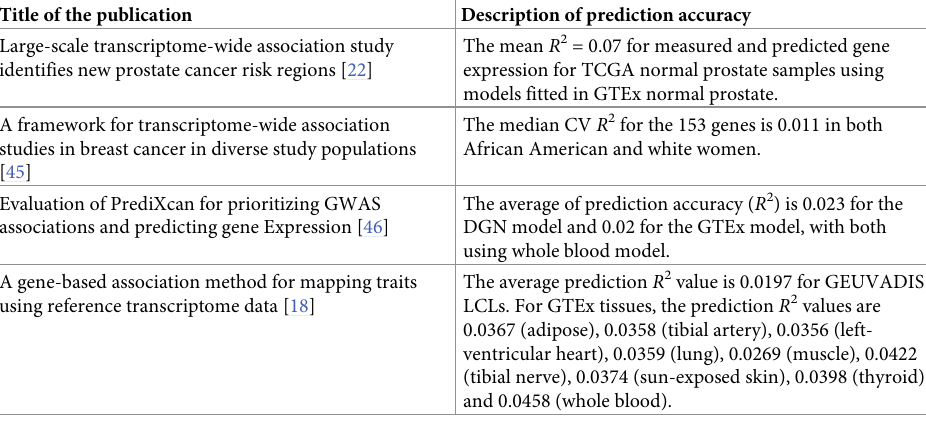
Table 2. Mean R 2 in published TWAS